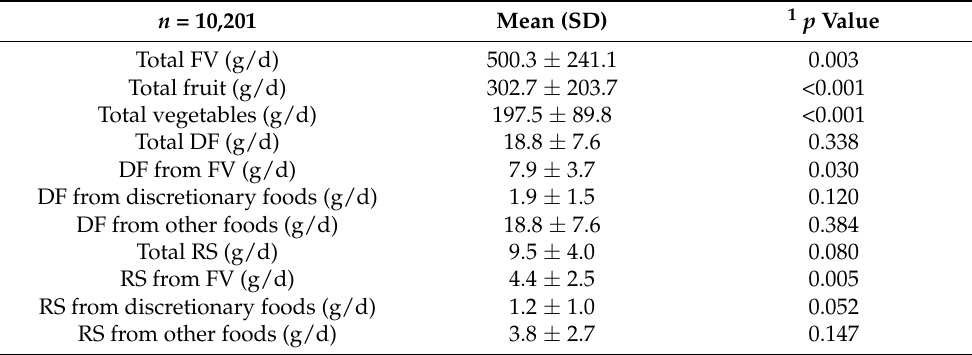
Table A2. The cross-sectional association of dietary intakes with MCS scores at baseline in 10,201 Australian adults from the AusDiab